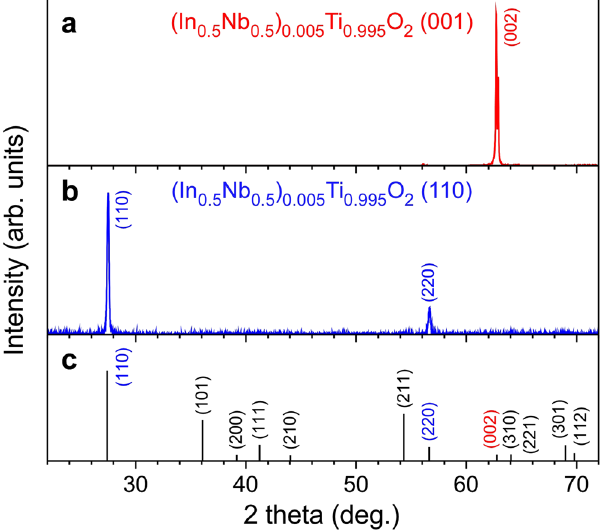
Figure 1. X-ray diffraction patterns of NITO-0.5% single crystals with ( a ) (001) and ( b ) (110) wide surfaces, wherein the incident X-ray was irradiated normal to the wide surface. The calculated diffraction pattern of TiO 2 is presented in Panel